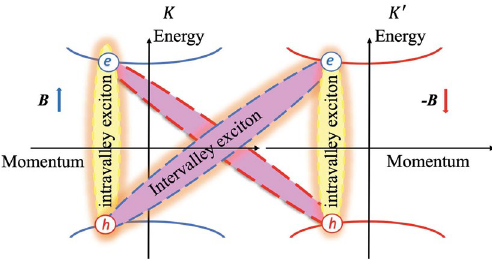
Figure 1. The schematic band structure and electronic dispersions in the graphene monolayer for bright intravalley and dark intervalley pseudo magnetoexcitons in the K and K ′ valleys. The second intervalley PME is shown by the dashed